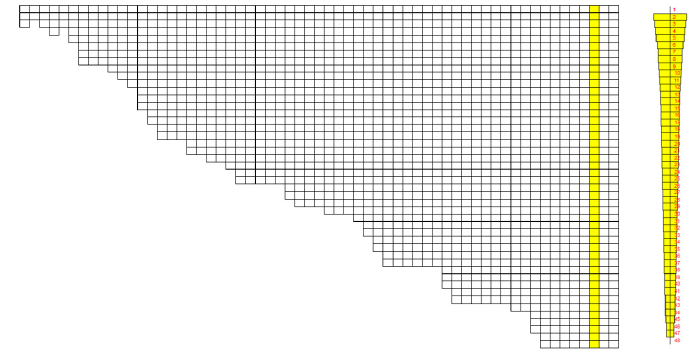
Figure 4. Reservoir grid model.